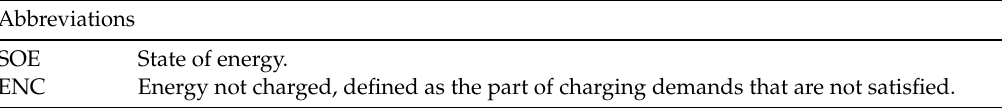
Table 1. List of notations and variables used in this